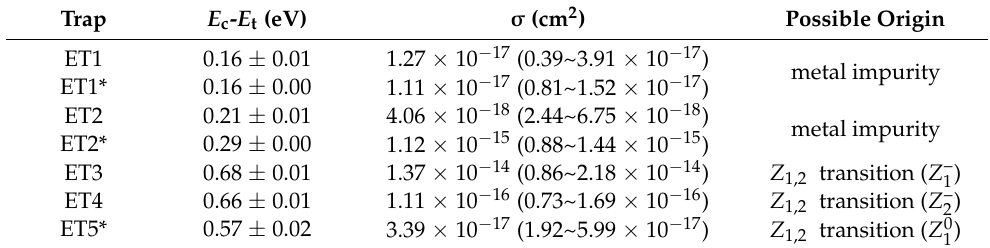
Figure 5. Fourier coefficient, b 1 , spectrum before the stress. The position of evaluated deep levels is verified by the simulation (solid lines). Table 1. Parameters of evaluated trap states. The asterisk (*) denotes the trap after stress conditions. The capture cross-section has an evaluated range of one standard